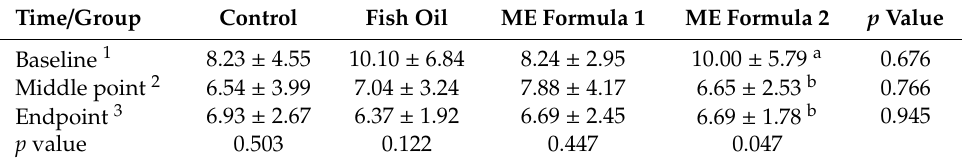
Table 5. Total amount of faecal fat (mg / g wet weight) in all groups over the 4 weeks. Time / Group Control